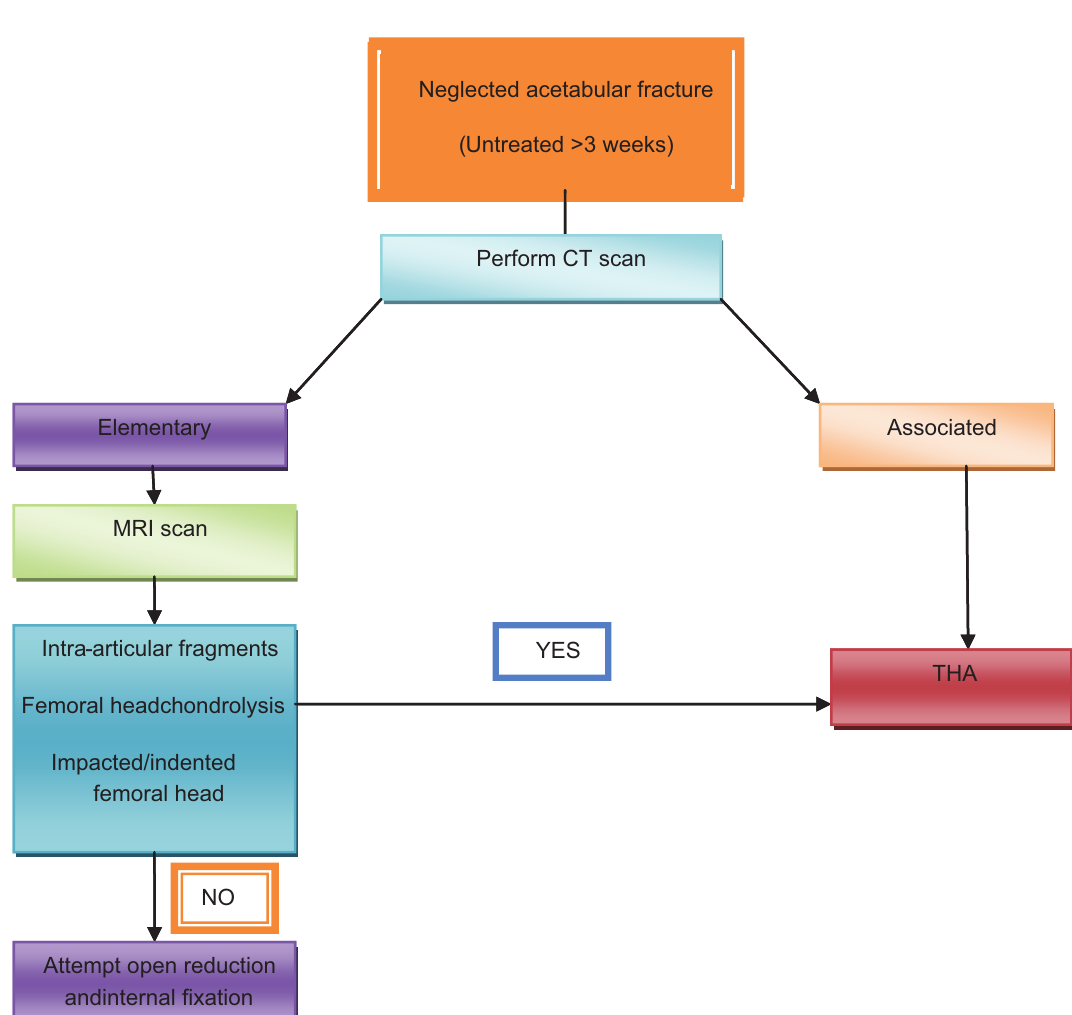
Figure 1. Recommended treatment approach for neglected acetabular fractures.